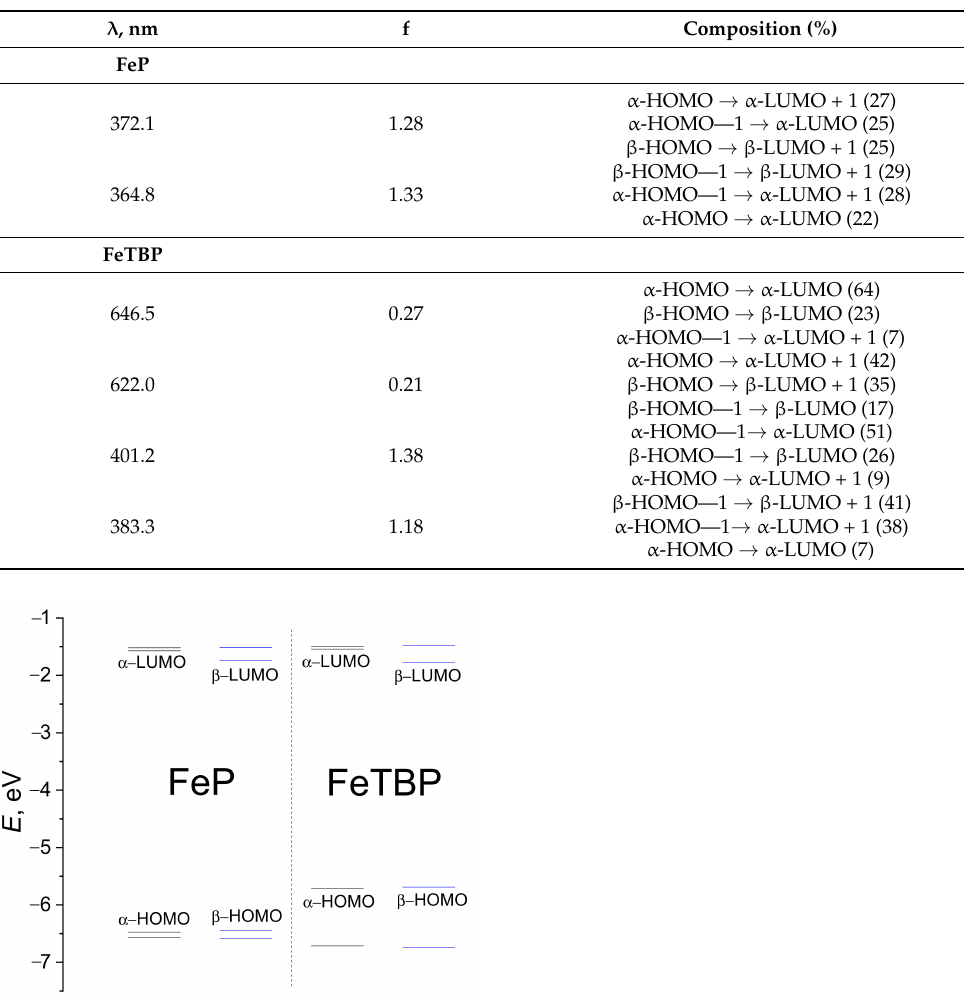
Figure 5. MO level diagram for FeP and FeTBP complexes according to UKS CAM-B3LYP/def2- TZVP calculations.